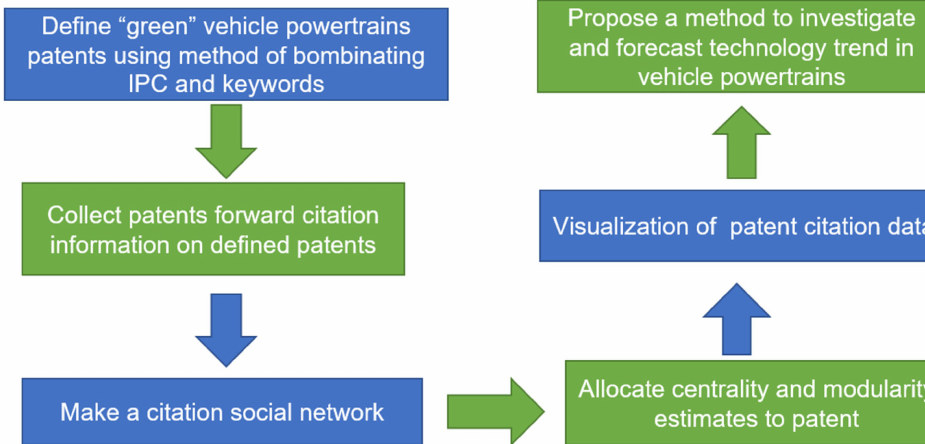
Figure 1. Schematic of research